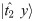
Concentration of |t2^y〉 over time in DSD realized catalytic reactions.(A) (|t^x〉,|t^u〉)=(0.001,0.001) in nM and (B) (|t^x〉,|t^u〉)=(100,100) in nM.